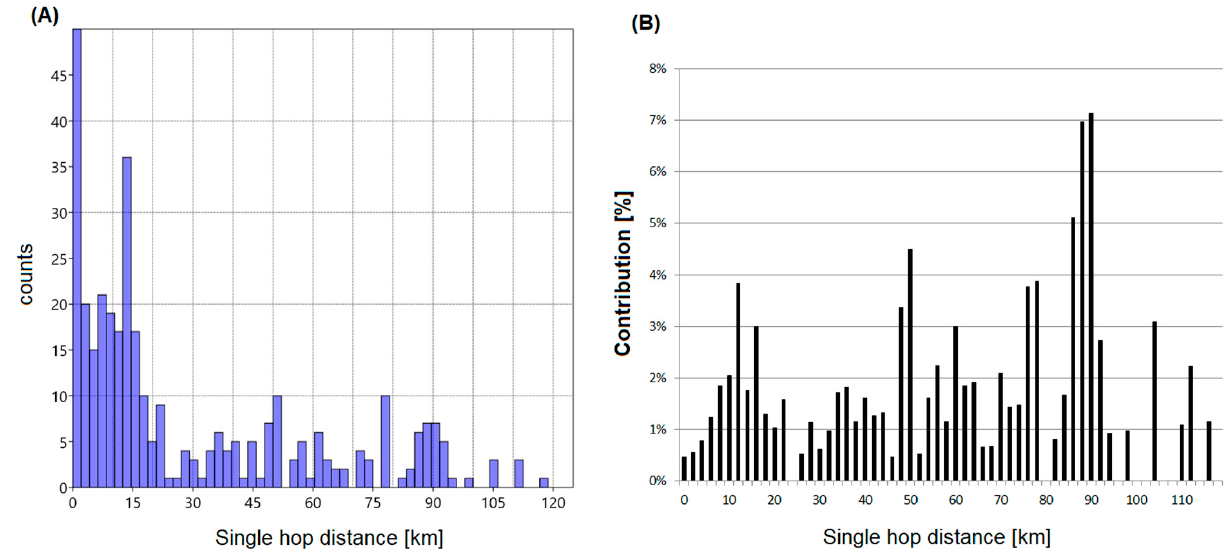
Figure 7. Distribution of single hop distances reported in optimizer solution ( A ) and cost contribution vs. distance value ( B ).